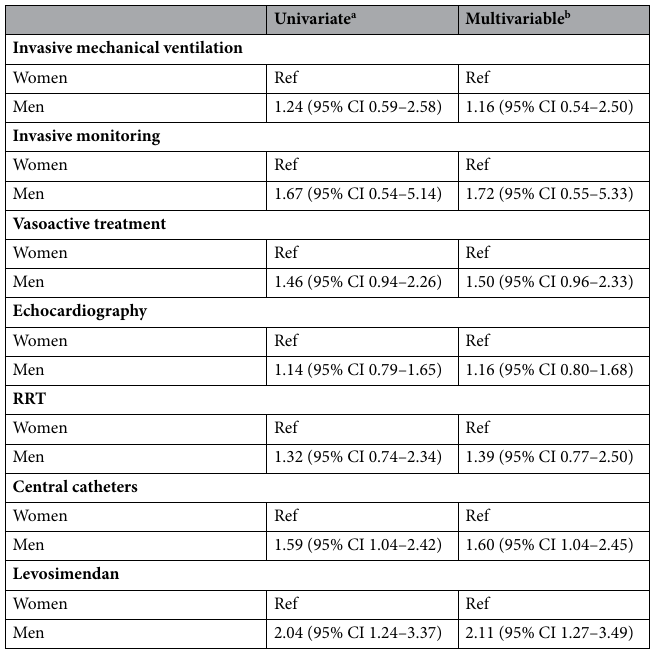
Table 4. Univariate and multivariate logistic regression analyses on patients admitted with cardiac arrest, exploring differences in the use of invasive mechanical ventilation, invasive monitoring, vasoactive treatment, echocardiography, RRT and placement of central catheters, based on the sex of the patient. Data presented as odds ratio and 95% CI. a 536 and 529 patients are included in univariate analyses and multivariable analyses respectively. b Adjusted for Age, Estimated mortality risk and Charlson Co-morbidity index. RRT Renal replacement therapy.